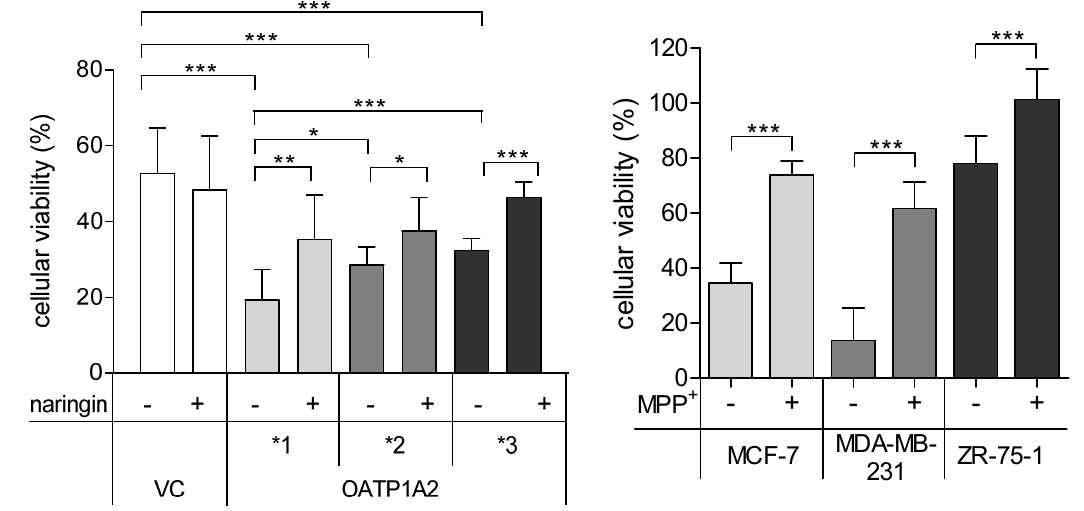
Figure 3. Cell viability of vector transfected (VC) HEK293 cells or cells expressing OATP1A2*1, *2, *3 after incubation with 100 µ mol/L doxorubicin for 72 h in presence (+) or absence ( − ) of 500 µ M naringin (left panel). Cell viability of breast cancer cell lines after incubation with 100 µ mol/L doxorubicin for 72 h in presence (+) or absence ( − ) of 100 µ M 1-methyl-4-phenylpyridinium (MPP+) (right panel). Viability was compared to cells incubated with DMSO as solvent for doxorubicin (=100%) (data given as mean ± SD; n = 3; * p < 0.05; ** p < 0.01; *** p < 0.001). The doxorubicin uptake was significantly reduced to 0.57–35% in the presence of 0.01% CrEL in cells stably expressing OATP1A2 and OCT1-3 (Figure 4A). In breast cancer